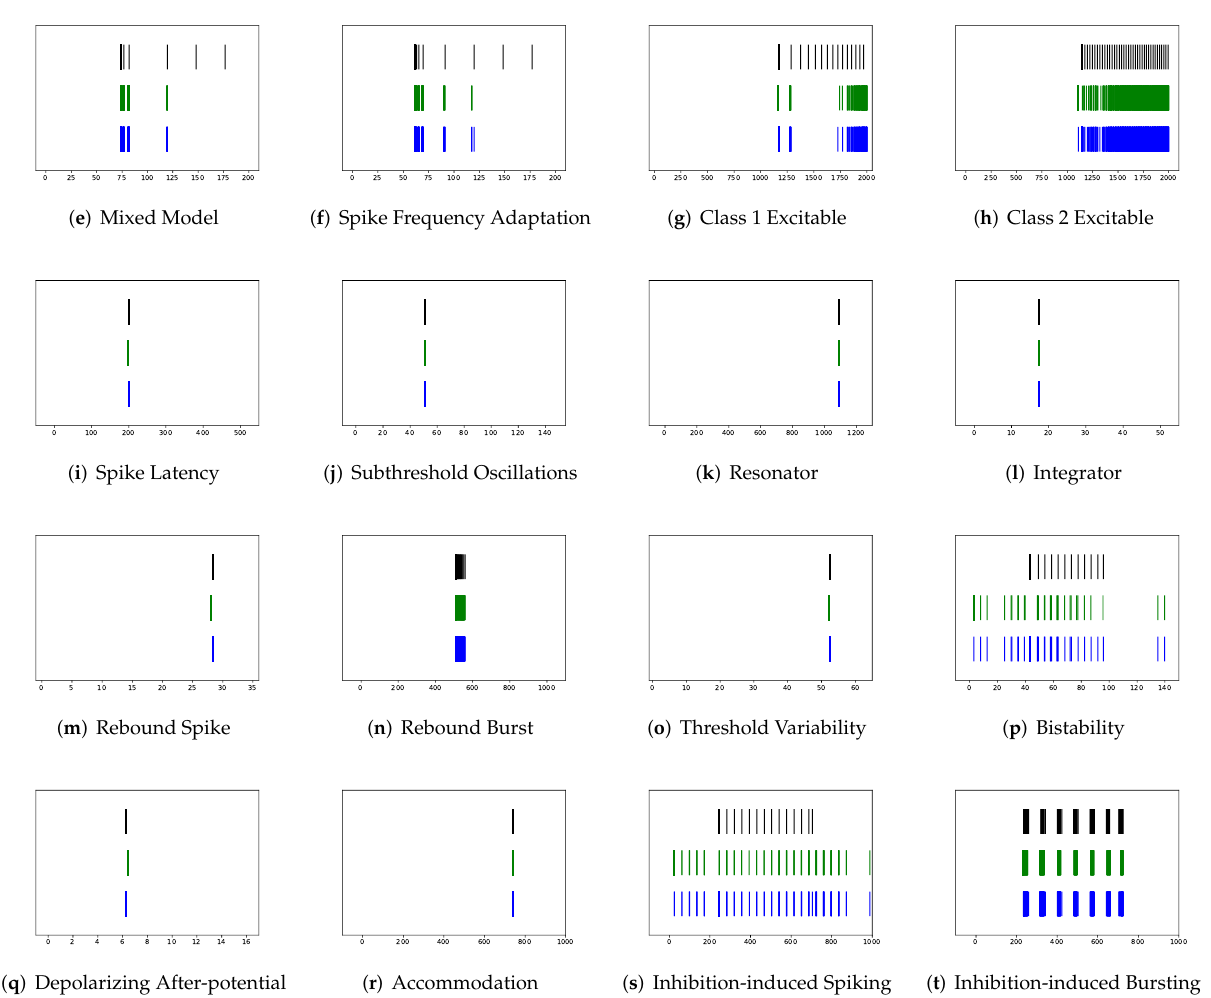
Figure 13. Spike trains of Izhikevich Model (black) vs. unmodified PCR (green) vs. modified PCR by maximum tolerance (blue), where x-axis is the time